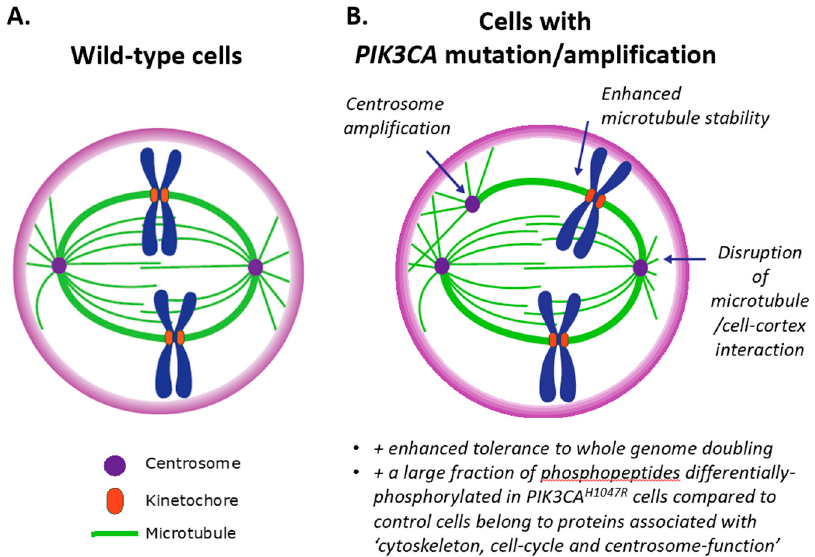
Figure 2. Deregulation by PIK3CA activation of microtubule ( A ) and centrosome biology ( B ) in relation to the regulation of the mitotic